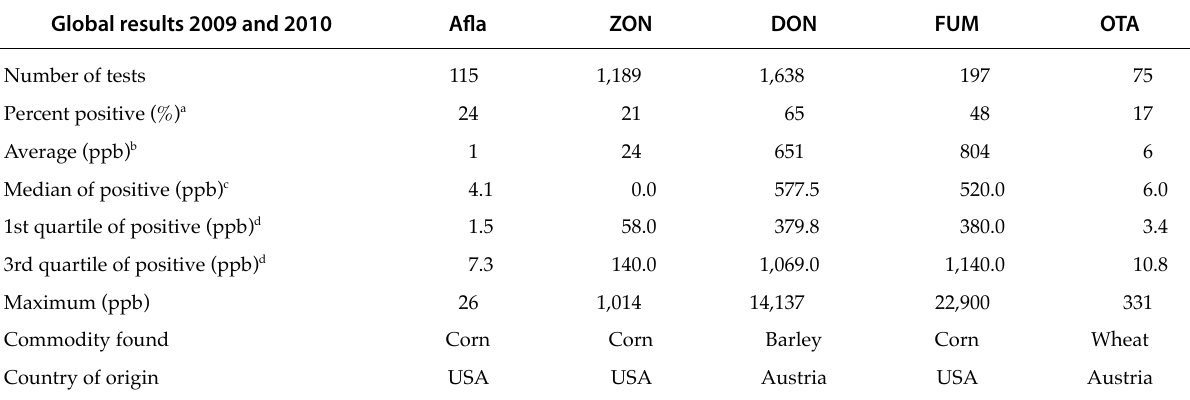
Table 2. Overview of the survey (ELISA). Global results 2009 and